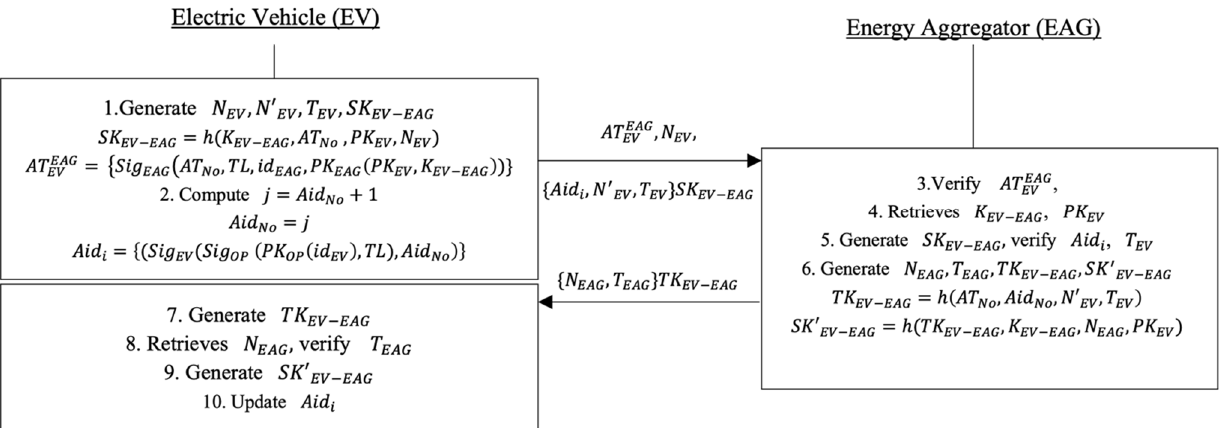
Figure 7. The proposed reauthentication phase.